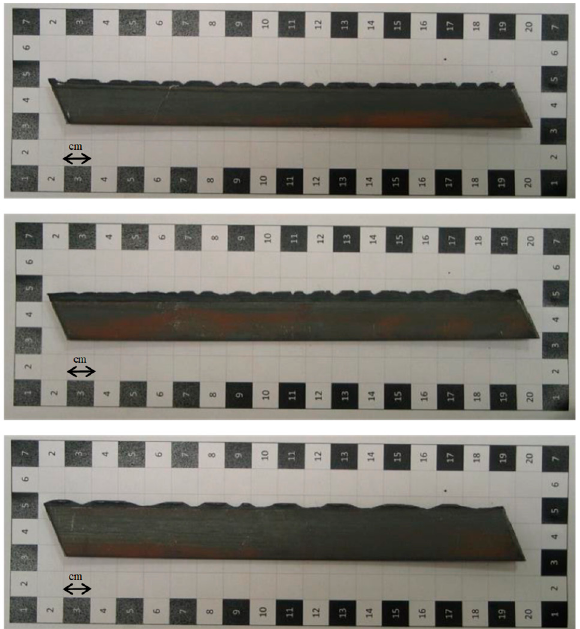
Figure 1. Specimens of flat bar in steel grade 1.4512 affected by jagged borders.